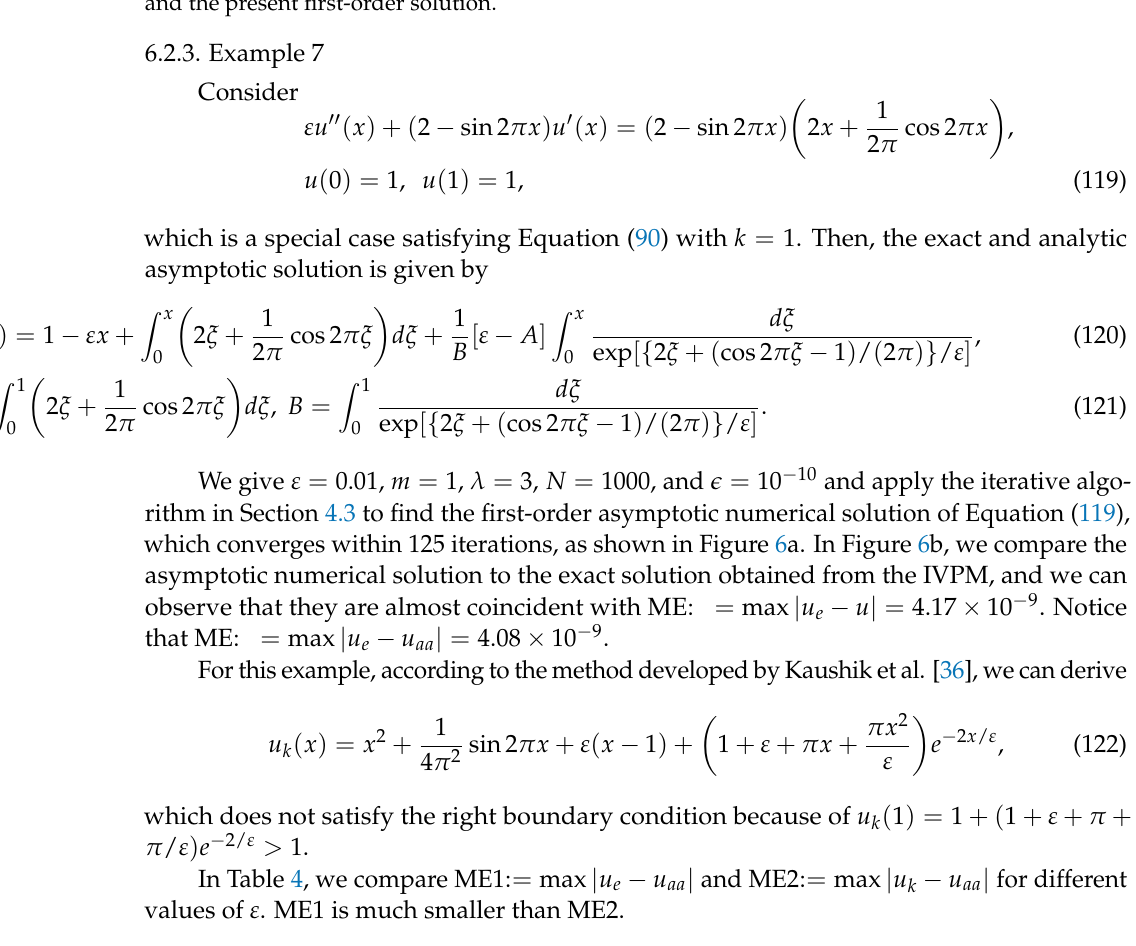
Figure 5. For example 6: ( a ) showing the convergence of iterations; and ( b ) comparing exact solution and the present first-order